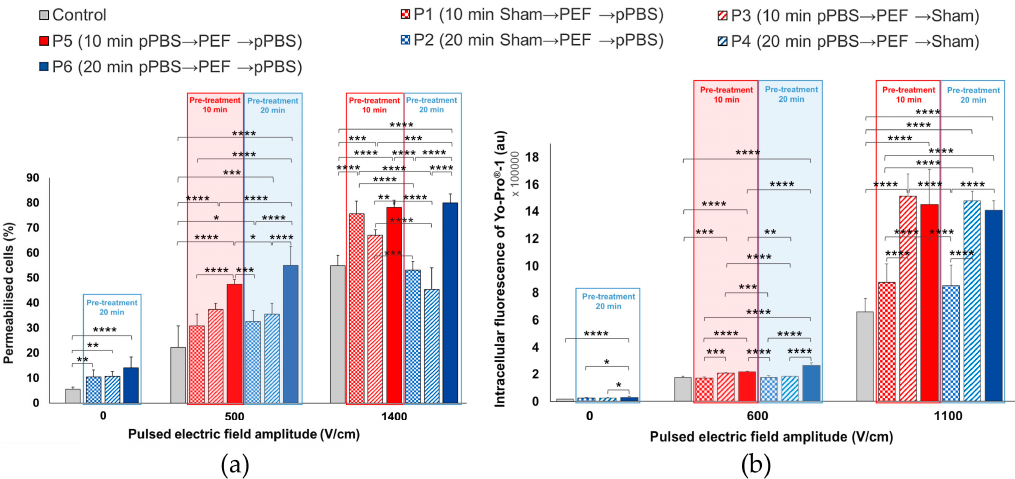
Figure 7. Effects of the combined treatment on adherent malignant B16-F10 melanoma cells using µsPEF at 0, 500, and 1400 V/cm. ( a ) Percentage of electropermeabilised cells and ( b ) intracellular fluorescence of YO-PRO ® -1 iodide entering the cells as a function of the seven combined protocols applied. Data are presented as mean (for a ) and median (for b ) values ± SD of independent triplicates. Statistical differences were analysed using One-way ANOVA followed by Bonferroni’s multiple comparison test. * p < 0.05, ** p < 0.01, ***, p < 0.001, and **** p < 0.0001 significant differences.